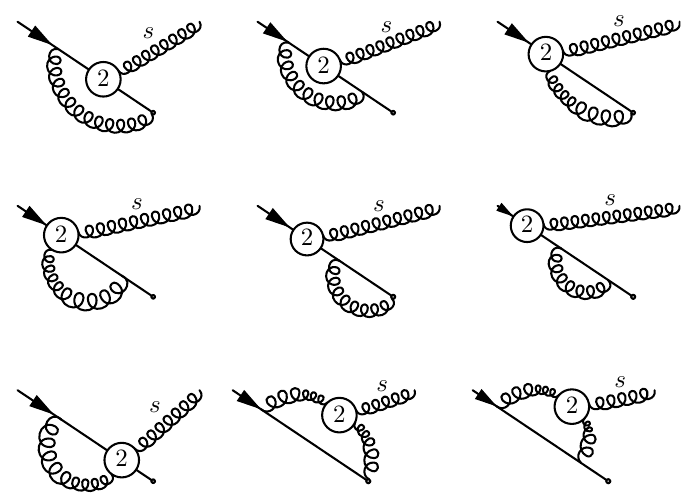
Figure 6 . One-loop collinear diagrams with one external soft gluon (labelled \s"). The dot at the right end of the solid quark line denotes the (cid:31) c (cid:12)eld from the LP current. The collinear gluon in the loop attaches either to the collinear quark or to the collinear Wilson line in the de(cid:12)nition of the (cid:31) c